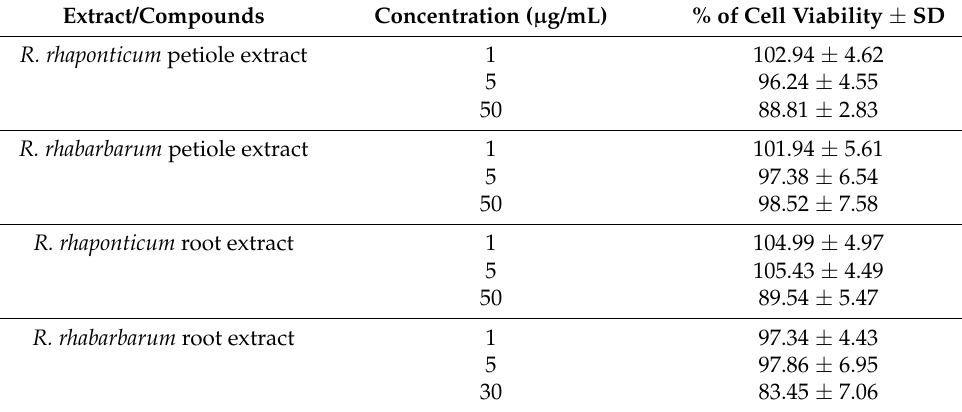
Table 3. The in vitro assessment of cytotoxicity of the examined rhubarb extracts and stilbenes towards HUVECs. Data are presented as mean ± SD, n = 4. The viability of control (untreated) HUVECs was assumed as 100%.